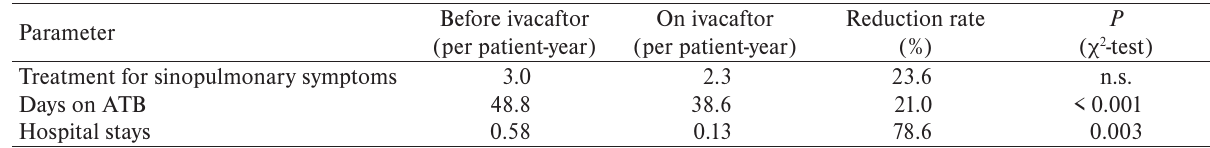
Table 2. Change in sinopulmonary-related